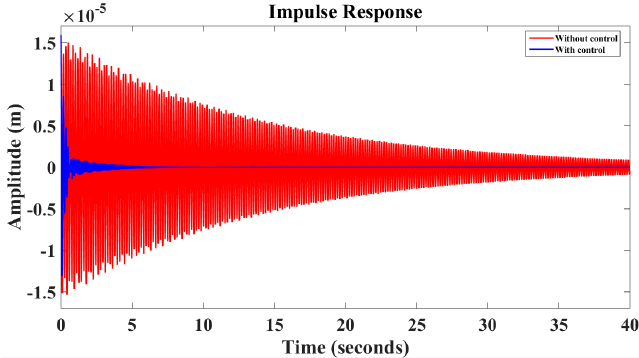
Figure 12. Impulse response of the beam (Sensors in FE3, Q = 10 12 , R = 1, Gc = 100).